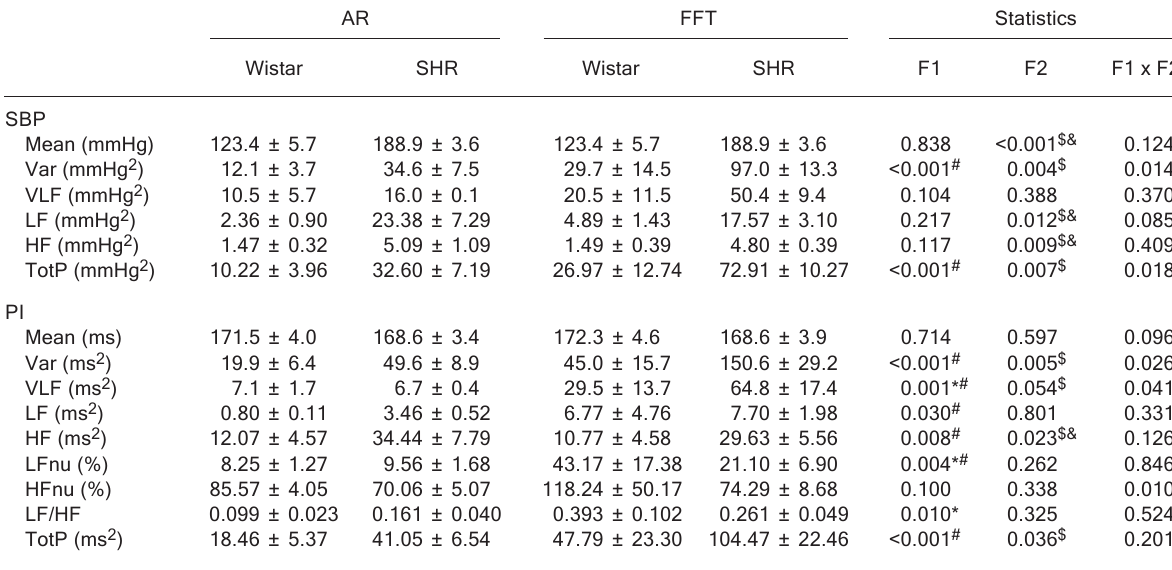
Table 5. Time- and frequency-domain analysis of systolic blood pressure (SBP) and pulse interval (PI) of normotensive (Wistar, N = 8) and spontaneously hypertensive (SHR, N = 8)